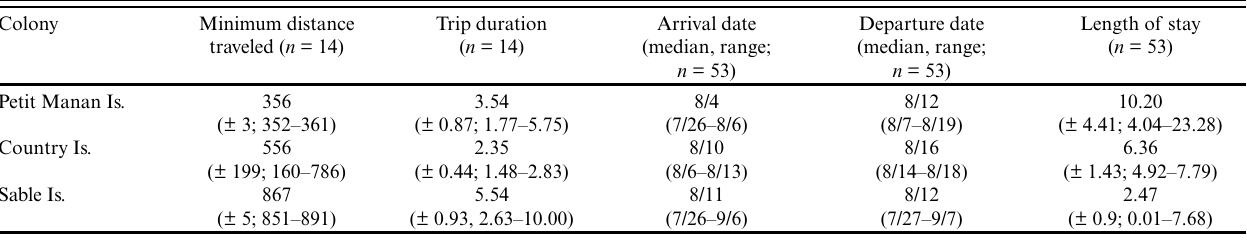
Table 3 . Mean (± SE and range) distance traveled (km) to postbreeding dispersal sites, duration (in days) of postbreeding dispersal movements (assuming Euclidian distances), length of stay (mean ± SE and range, in days), and dates (median and range) of arrival and departure at postbreeding dispersal sites of Common Terns ( Sterna hirundo ) from three nesting colonies throughout the western North Atlantic in 2013.